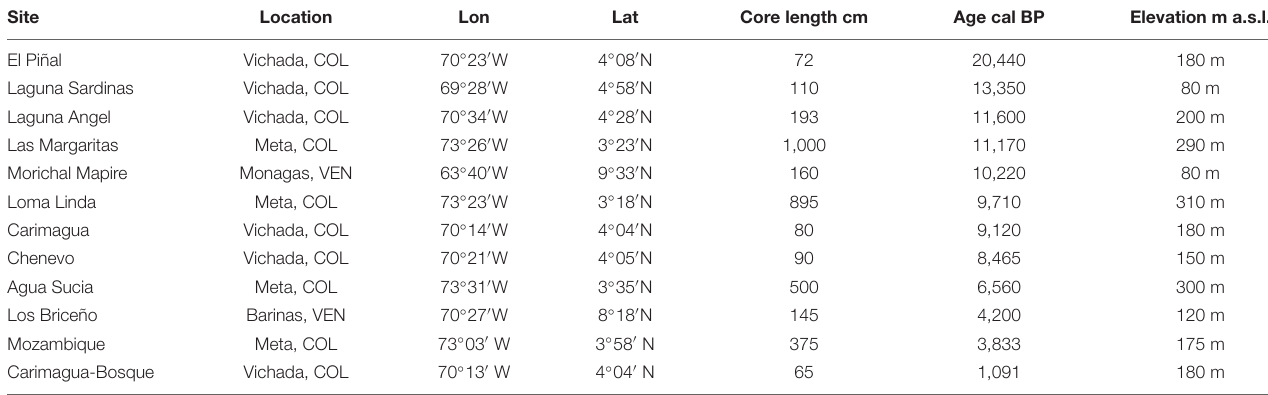
TABLE 1 | Site details with location, coordinates (lon/lat), core length in cm, estimated calibrate bottom ages in yr BP and site elevation in m above sea level (a.s.l.). Site Location Lon Lat Core length